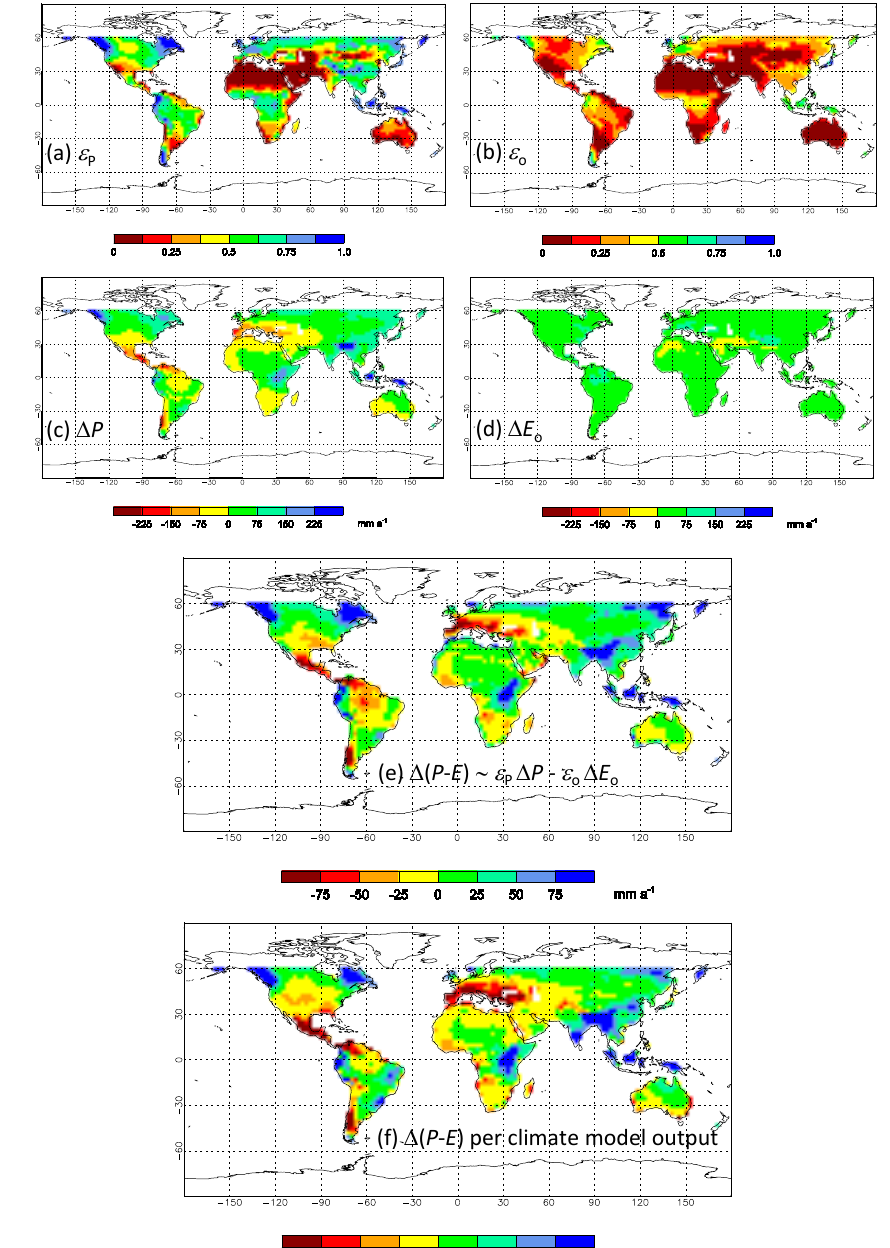
Fig. 3. Comparison of 1 ( P − E ) estimated using the Budyko-based framework versus 1 ( P − E ) calculated from climate model output. Components of the Budyko-based approach include (a) ε P (Eq. (4)), (b) ε o (Eq. (4)), (c) 1P (per climate model output), (d) 1E o (per climate model output) and the (e) calculated change, 1 ( P − E ) ∼ ε P 1P − ε o 1E o (Eq. (4)) compared with (f) 1 ( P − E ) calculated directly from the climate model